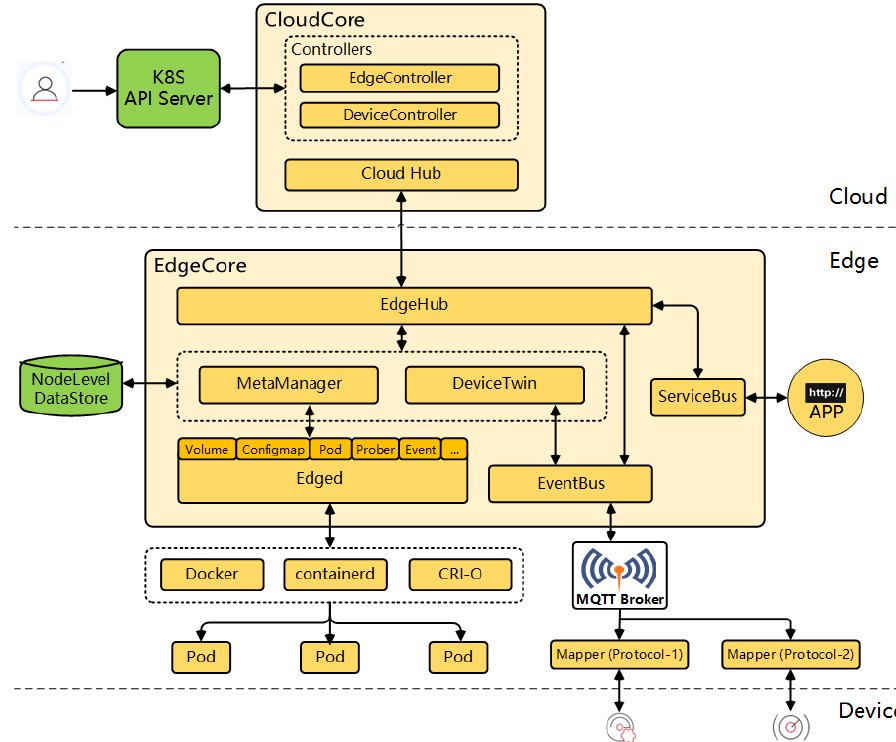
Figure 3. KubeEdge architecture [66].